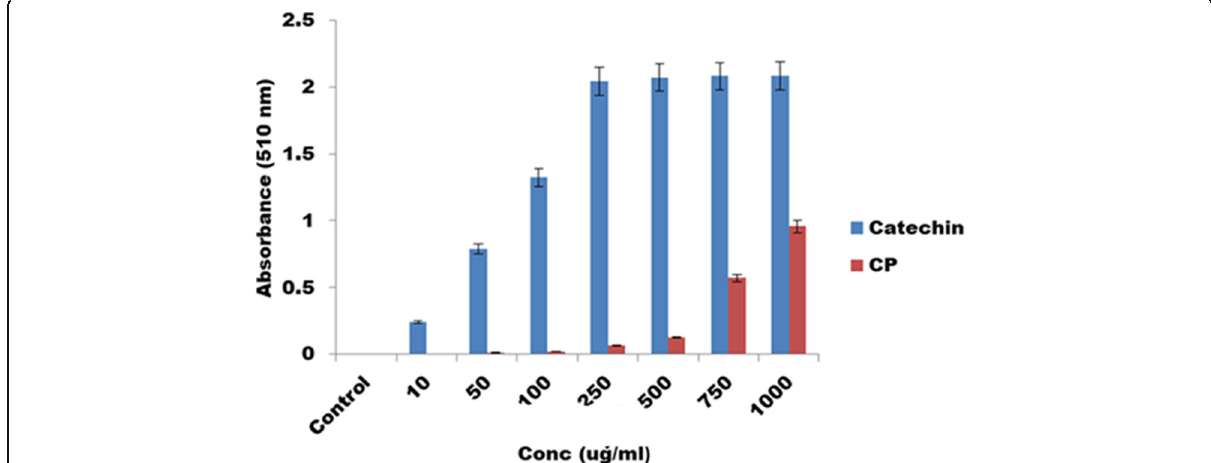
Fig. 4 Flavonoid content of Calotropis procera leaf. It revealed that at 1000 ug/ml, the flavonoid content was similar to the standard catechin. Data are expressed as mean ± SD ( n = 4)